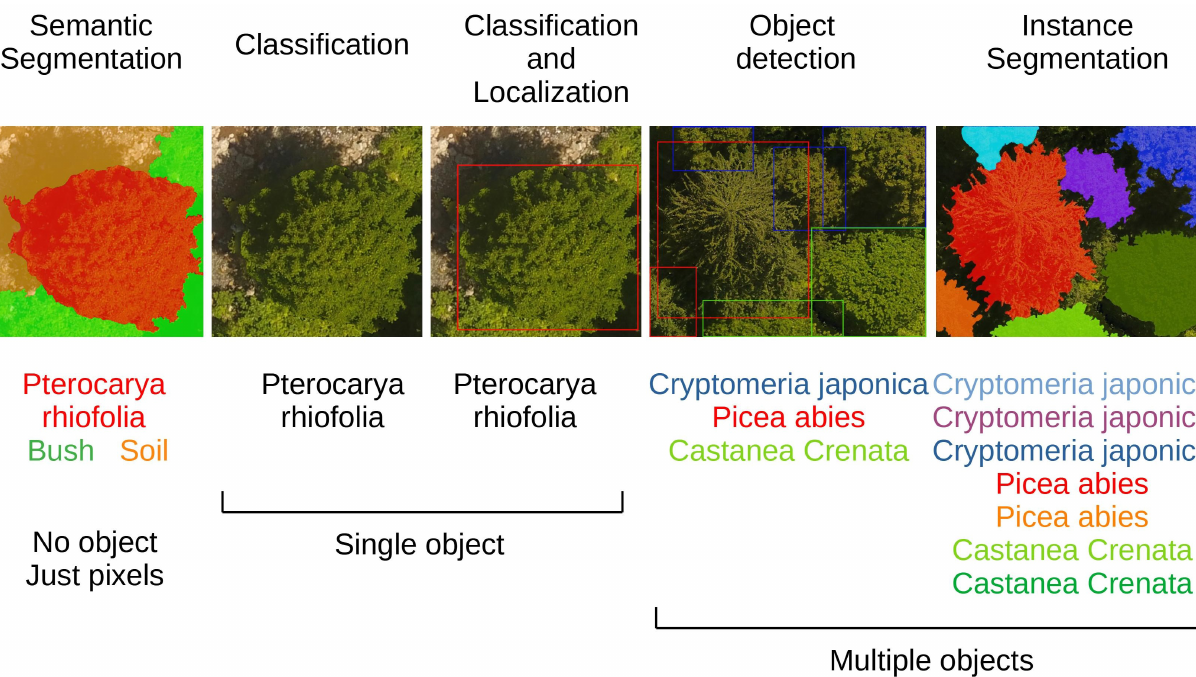
Figure 3. Examples of different computer vision problems considered in this